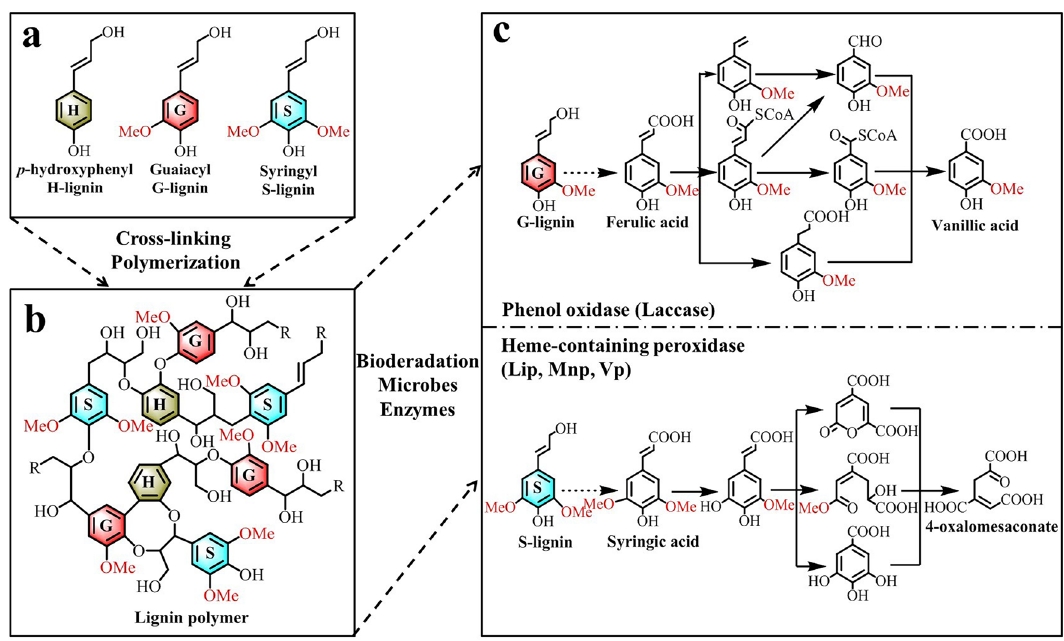
Figure 4. The ( a ) chemical structures, ( b ) polymeric structures, and ( c ) biodegradation pathways for lignin- based aromatic compounds 15 . Lip, lignin peroxidase; Mnp, manganese peroxidase; Vp, versatile